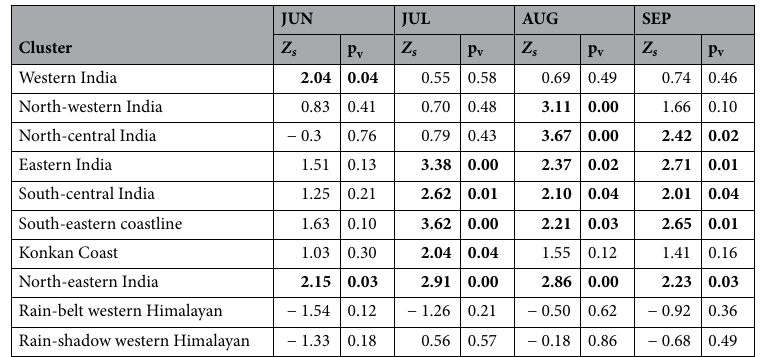
Table 1. MK test result for each homogenous region’s CDHE spatial extent during the Indian summer monsoon months. Z s is the Mann–Kendal Z statistic; p v is the p-value corresponding to Z s ; Bold text has rejected the null hypothesis, i.e. there is a significant trend in spatial extent at a 95% confidence level (p-value ≤ 0.05, see Text S1).